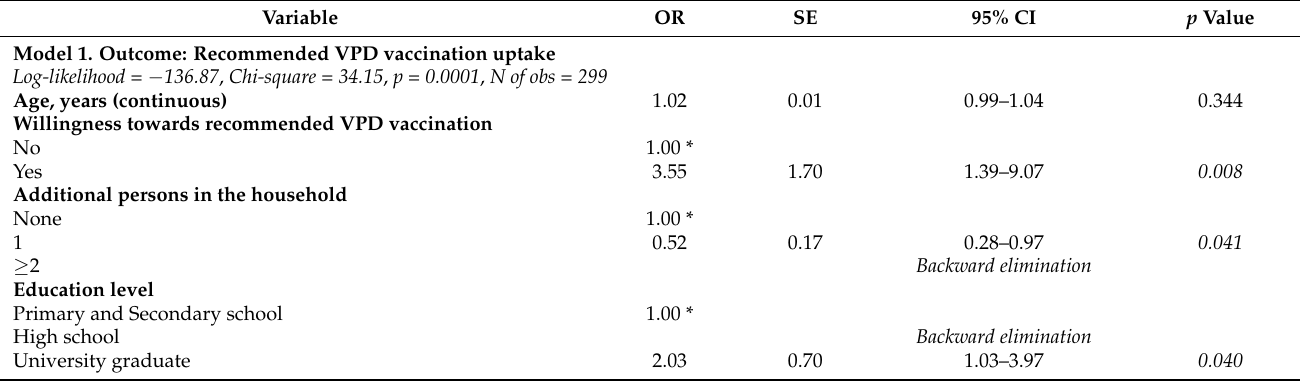
Table 3. Multiple logistic regression analysis results to estimate the associations of recommended VPD vaccination uptake in frail subjects with several